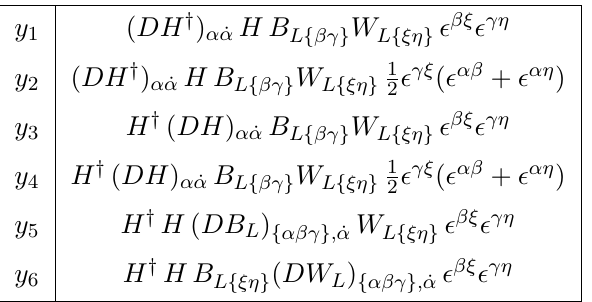
Table 3 . Operators of the type D ( H y HB L W L ) that are gauge-invariant but sit in the Lorentz four-vector representation. The number of operators in this class can be generated automatically via the same procedure that projects out the number of total invariants. As in table 2, we have suppressed SU(2) w